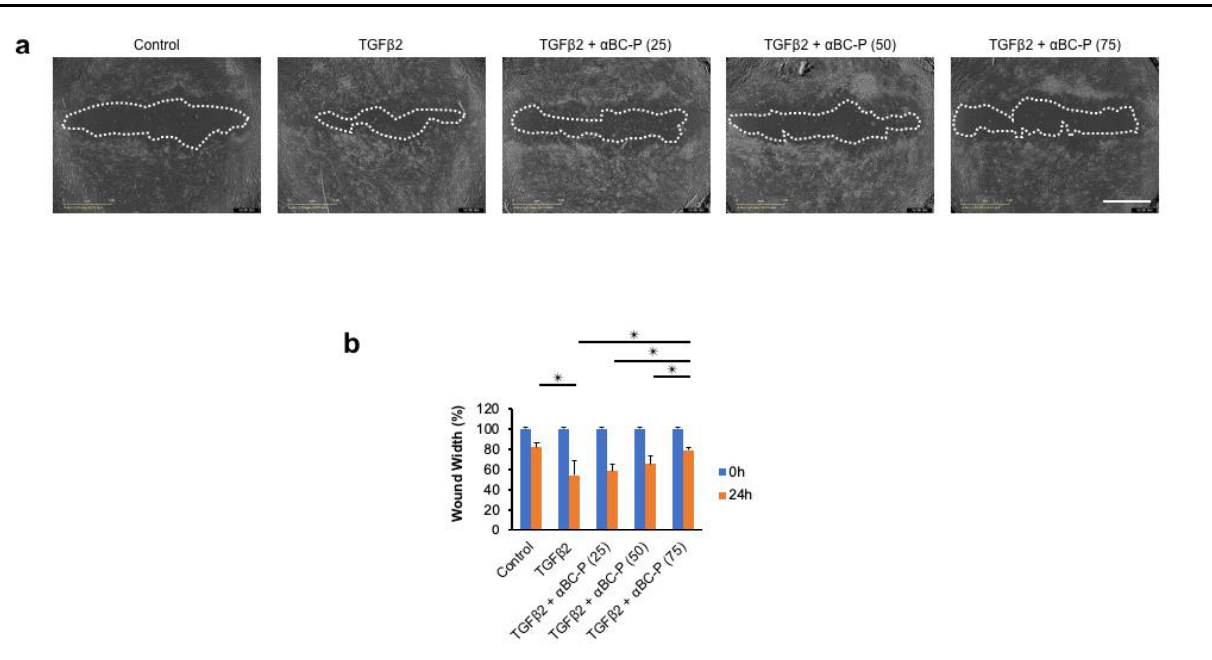
Figure 7. αBC - P inhibits TGFβ2 -induced hRPE cell migration. Representative images ( a ) and graphs Figure 7. α BC-P inhibits TGF β 2-induced hRPE cell migration. Representative images ( a ) and graphs ( b ) of wound width in RPE cells co-treated with TGFβ2 and αBC -P. hRPE cells were divided into ( b ) of wound width in RPE cells co-treated with TGF β 2 and α BC-P. hRPE cells were divided into following treatment groups: control, TGFβ2 (10 ng /mL) and/or αBC -P (25, 50 and 75 μg /mL) for 24 following treatment groups: control, TGF β 2 (10 ng/mL) and/or α BC-P (25, 50 and 75 µ g/mL) for h. αBC - P (75 μg/mL) significantly inhibited TGFβ2 - treated hRPE cell migration compared to TGFβ2 - 24 h. α BC-P (75 µ g/mL) significantly inhibited TGF β 2-treated hRPE cell migration compared to only treated hRPE cells. αBC - P: αB crystallin -chaperone peptide. Scale bar : 1 mm. Values are means TGF β 2-only treated hRPE cells. α BC-P: α B crystallin-chaperone peptide. Scale bar : 1 mm. Values are ± SEM. * p < 0.05. n = 8. means ± SEM. * p < 0.05. n =